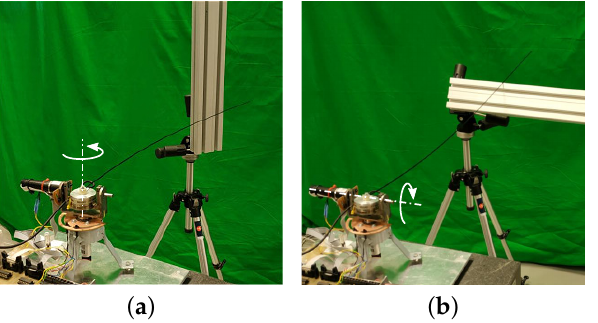
Figure 15. Setups of the experiments of azimuthal ( a ) and vertical ( b ) movements to make the contact with the object.